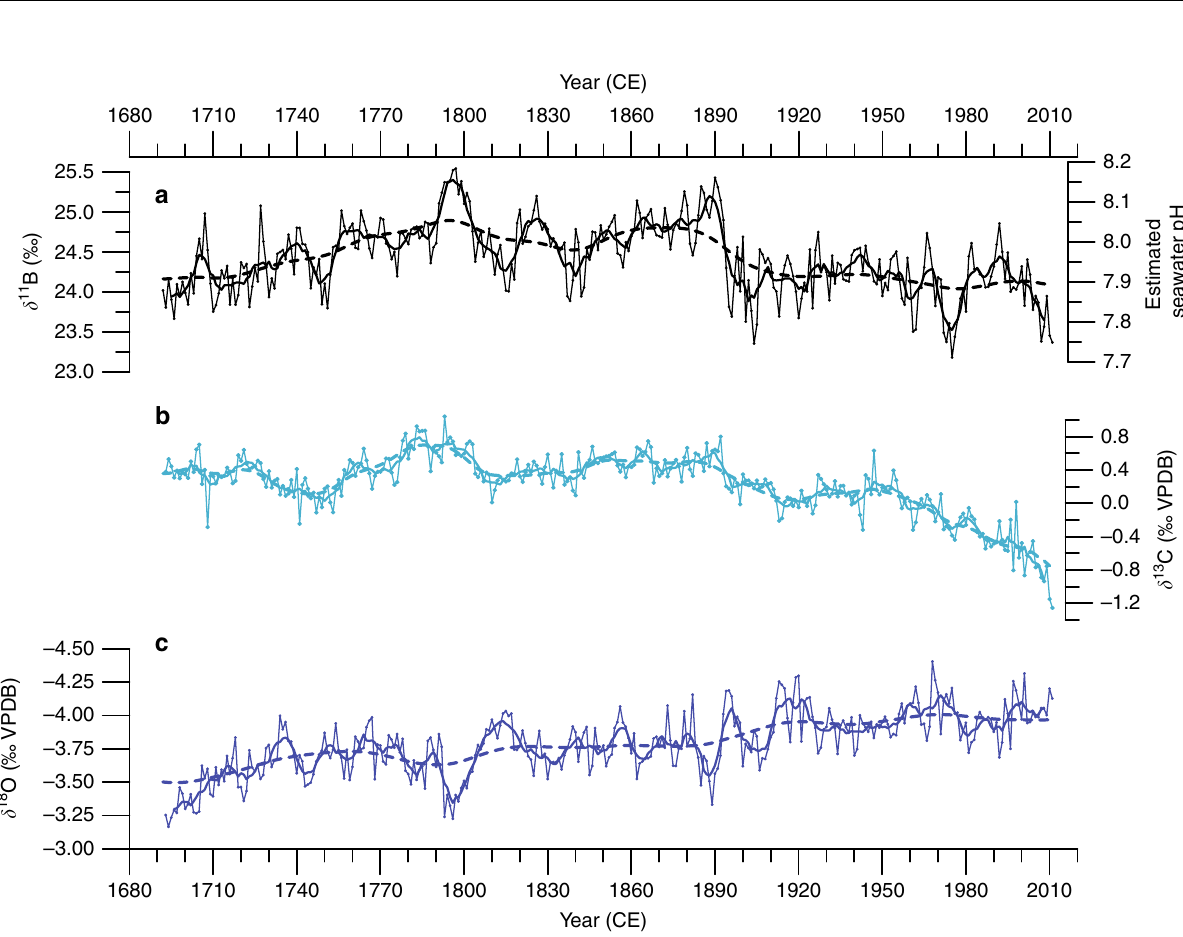
Fig. 2 Diploastrea heliopora coral proxy records and δ 11 B-pH reconstruction. New Caledonia D. heliopora annually resolved records over the period 1689 – 2011 CE from precisely dated 230 Th/U-age (see Methods). a Coral δ 11 B signature (left y axis) with estimated seawater pH (pH SW ) on the right y axis using the 35 ) following the conversion equations of refs. 34 and 39 (see Methods δ 11 B = 39.61 ‰ (ref. 67 ) and isotopic fractionation factor ( α SW [B3-B4] ) of 1.0272 (ref. for Eqs. (1) and (2)). b Coral δ 13 C ( ‰ VPDB) and c δ 18 O ( ‰ VPDB) ratios. To highlight the interannual variability, we applied a 7-year smoothing to the records (bold lines). The long-term secular trends of each time series (dashed lines) indicate the long-term changes and analysed by Bayesian